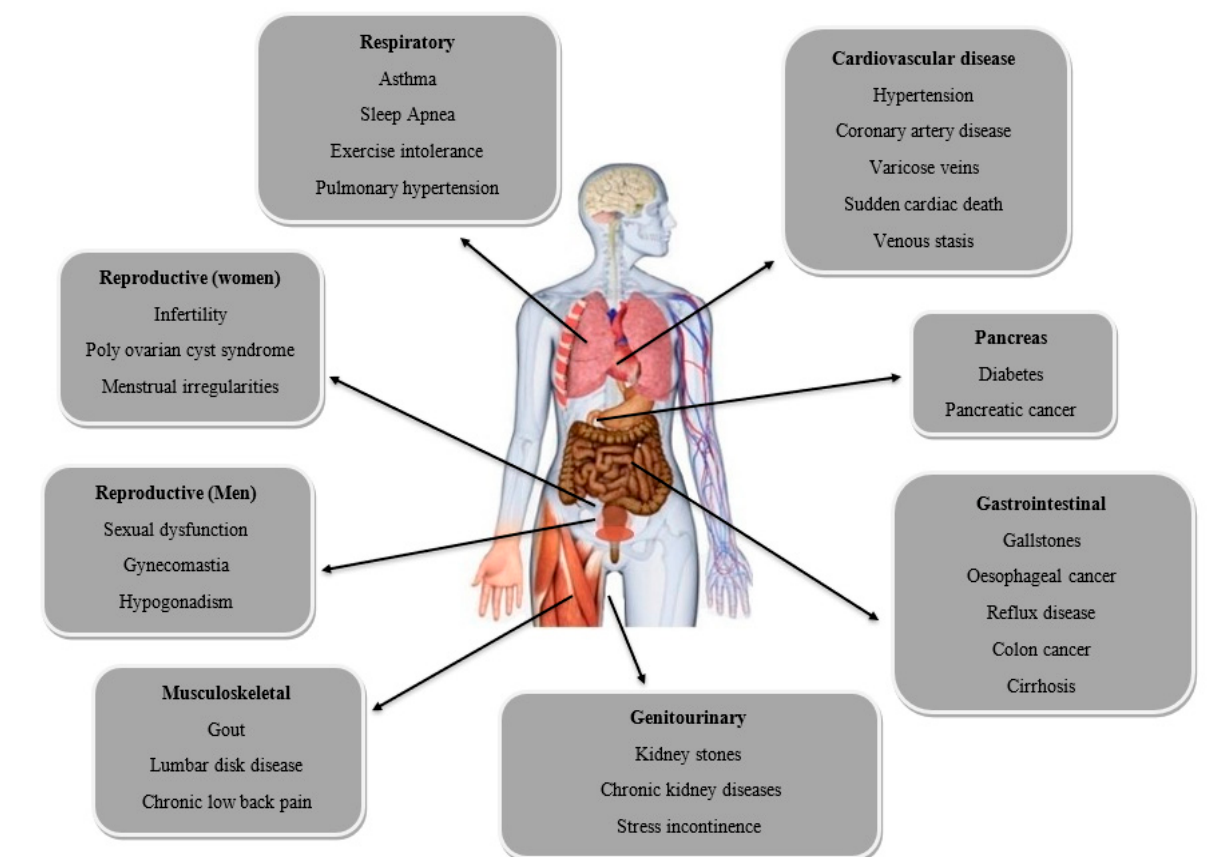
Figure 2. Several complications as a result of obesity.